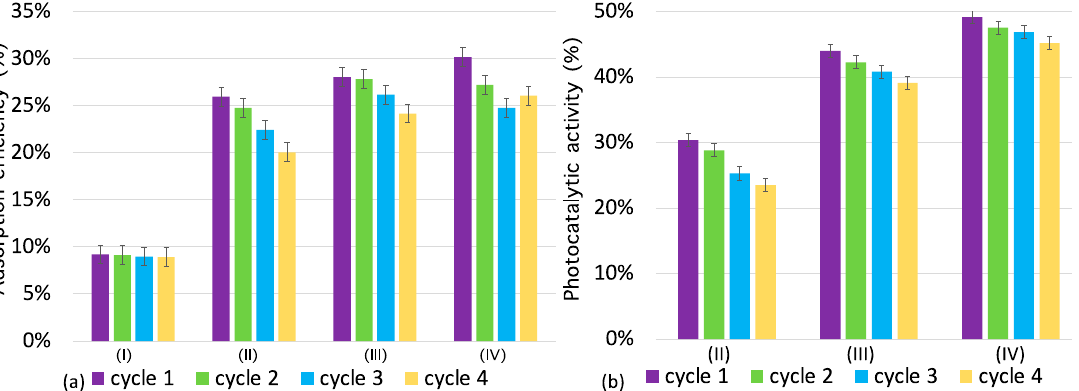
Figure 8. ( a ) Comparation among adsorption and ( b ) photocatalytic efficiency of modified and unmodified TiO 2 films after 4 cycles. Inside figure: (I) TiO 2 , (II) TCPP/TiO 2 , (III) TCPP/ZnPOM/TiO 2 and (IV) TCPP/CuPOM/TiO 2 .